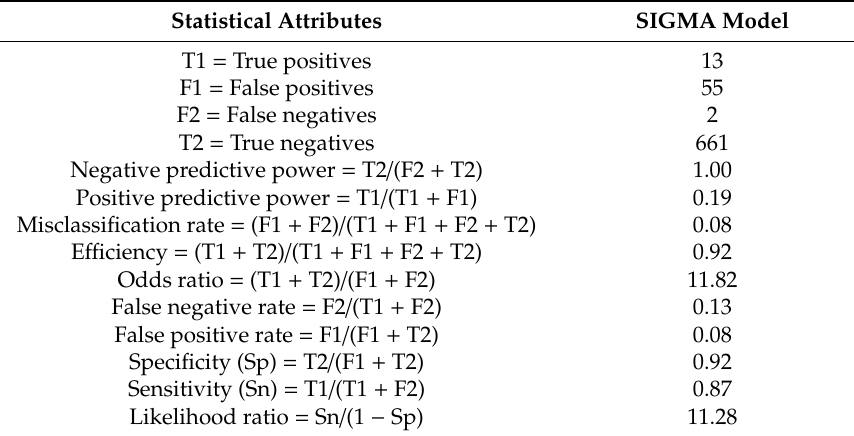
Table 2. Validation of the SIGMA model for Kalimpong.